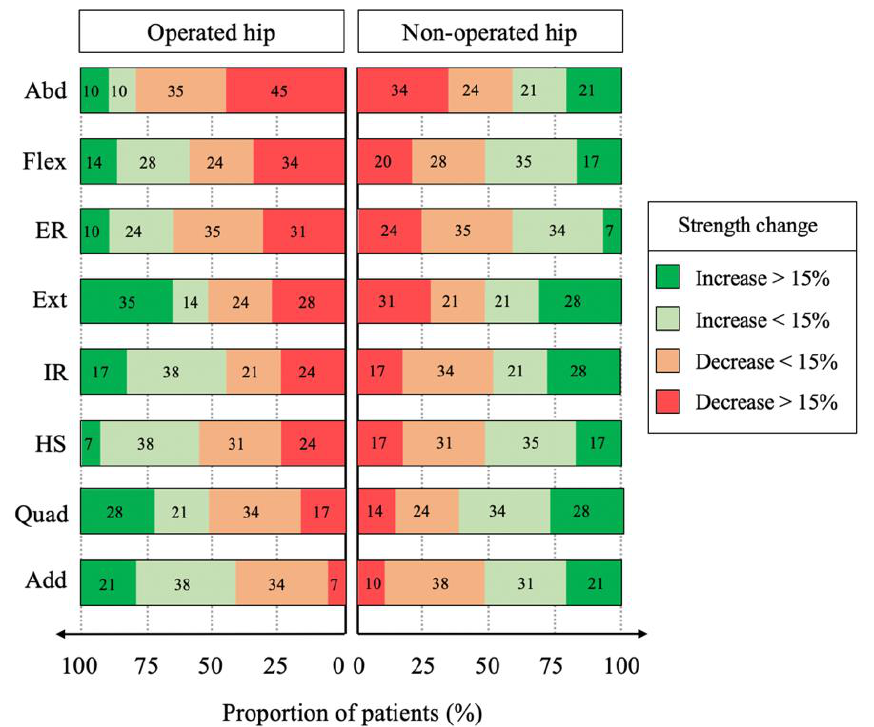
Figure 3. Proportion of patients with increased or decreased hip muscle strength on the operated and non-operated sides. Quadriceps (Quad), hamstrings (HS), extensor (Ext), flexors (Flex), abductors (Abd), adductors (Add), internal rotators (IR), external rotators (ER). The correlation of muscles strength change between the operated and non-operated hips was moderate for the abductors (r = 0.56; 95%CI, 0.24 – 0.77) and strong for the ham- strings (r = 0.78; 95%CI, 0.57 – 0.89), flexors (r = 0.75; 95%CI, 0.52 – 0.87) and external rotators (r = 0.73; 95%CI, 0.50 – 0.87) (Figure 4). r = 0.78 O p e r a t e d h i p Hamstrings strength change (Nm/kg) r = 0.75 Flexors strength change (Nm/kg) O p e r a t e d h i p Abductors strength change (Nm/kg) r = 0.56 External rotators strength change (Nm/kg) r = 0.73 Non-operated hips O p e r a t e d h i p s